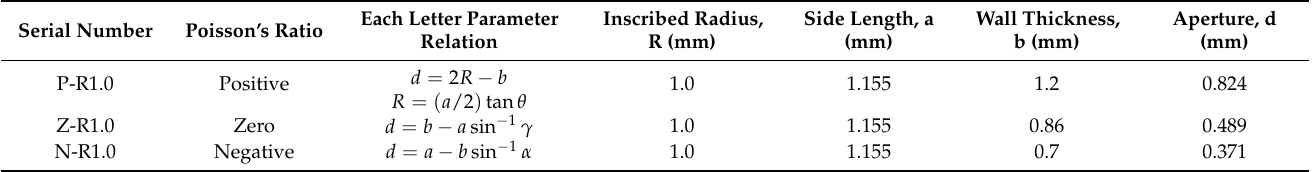
Table 1. Unit geometry of different Poisson’s ratio structures and relevant dimensional parameters.